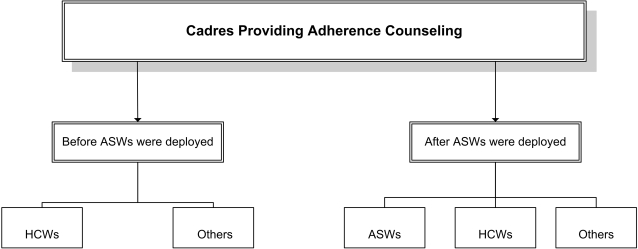
Type of Cadres Providing Adherence Counseling Services.This figure shows the type of cadres that were providing adherence counseling services before and after adherence support workers (ASWs) were deployed in the health facilities. Health Care Workers (HCWs) and other untrained staff such as data entry clerks, registration officers provided adherence counseling prior to the ASW intervention. After ASWs were introduced, they joined the above mentioned cadres in providing adherence counseling services.